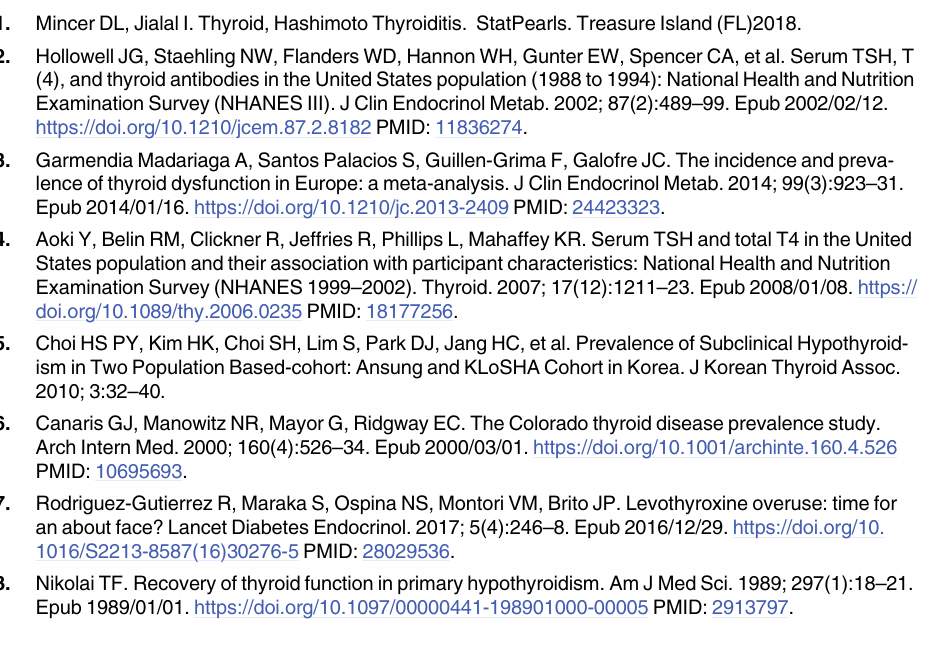
S2 Table. Predicting performance of each clinical feature and a decision tree model. S3 Table. Clinical and biochemical response during L–T4